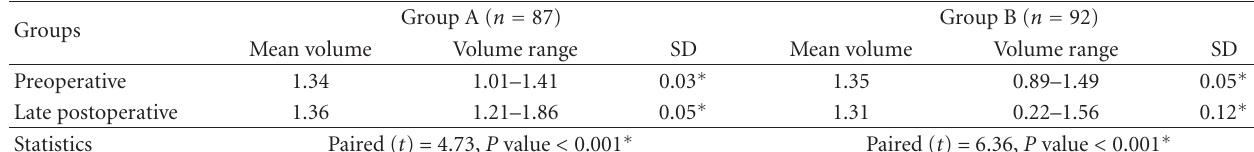
Table 4: Evaluation of volume of testis in males of both groups.